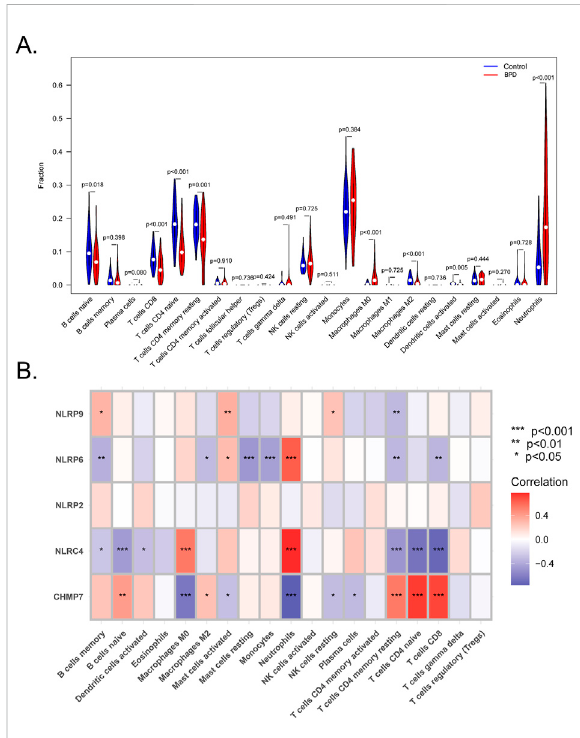
FIGURE 7 Analysis of the immune landscape. (A) CIBERSORT algorithm to evaluate the differences in the immune microenvironment between BPD and control samples. (B) Correlations between immune cells and the fi ve marker genes. (* p < 0.05, ** p < 0.01, *** p <